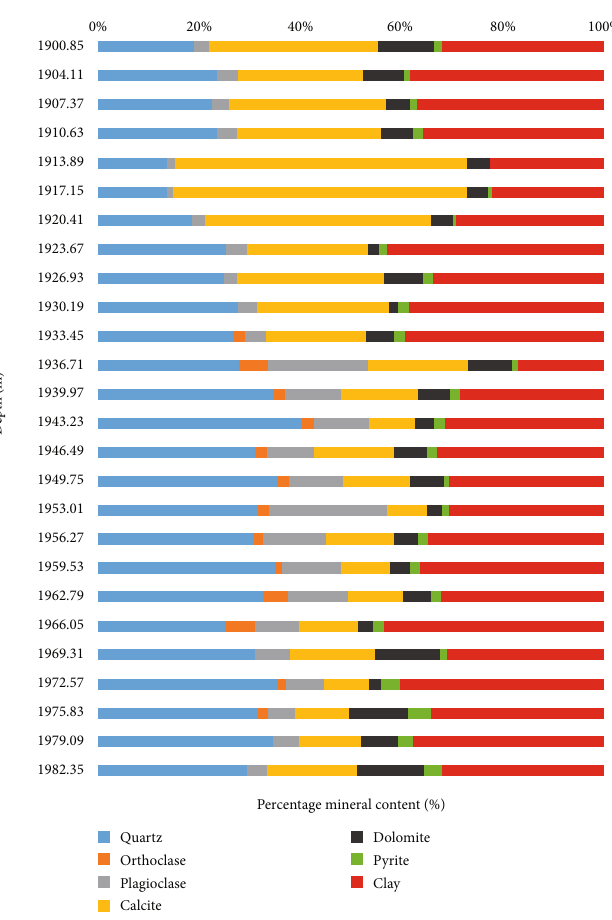
Figure 6: Vertical distribution of LF mineral components in well